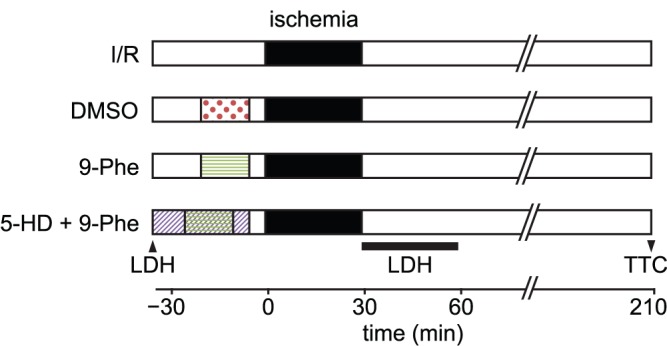
Experimental protocol.All experimental groups were first perfused for 20 min to allow the isolated hearts to stabilize. The hearts were then divided into groups as follows: ischemia–reperfusion (I/R), DMSO-treated, 9-Phe-treated, and 5-HD+9-Phe-treated. LDH measurement was carried out before drug application and after ischemia. Finally, the heart was used for TTC analysis.